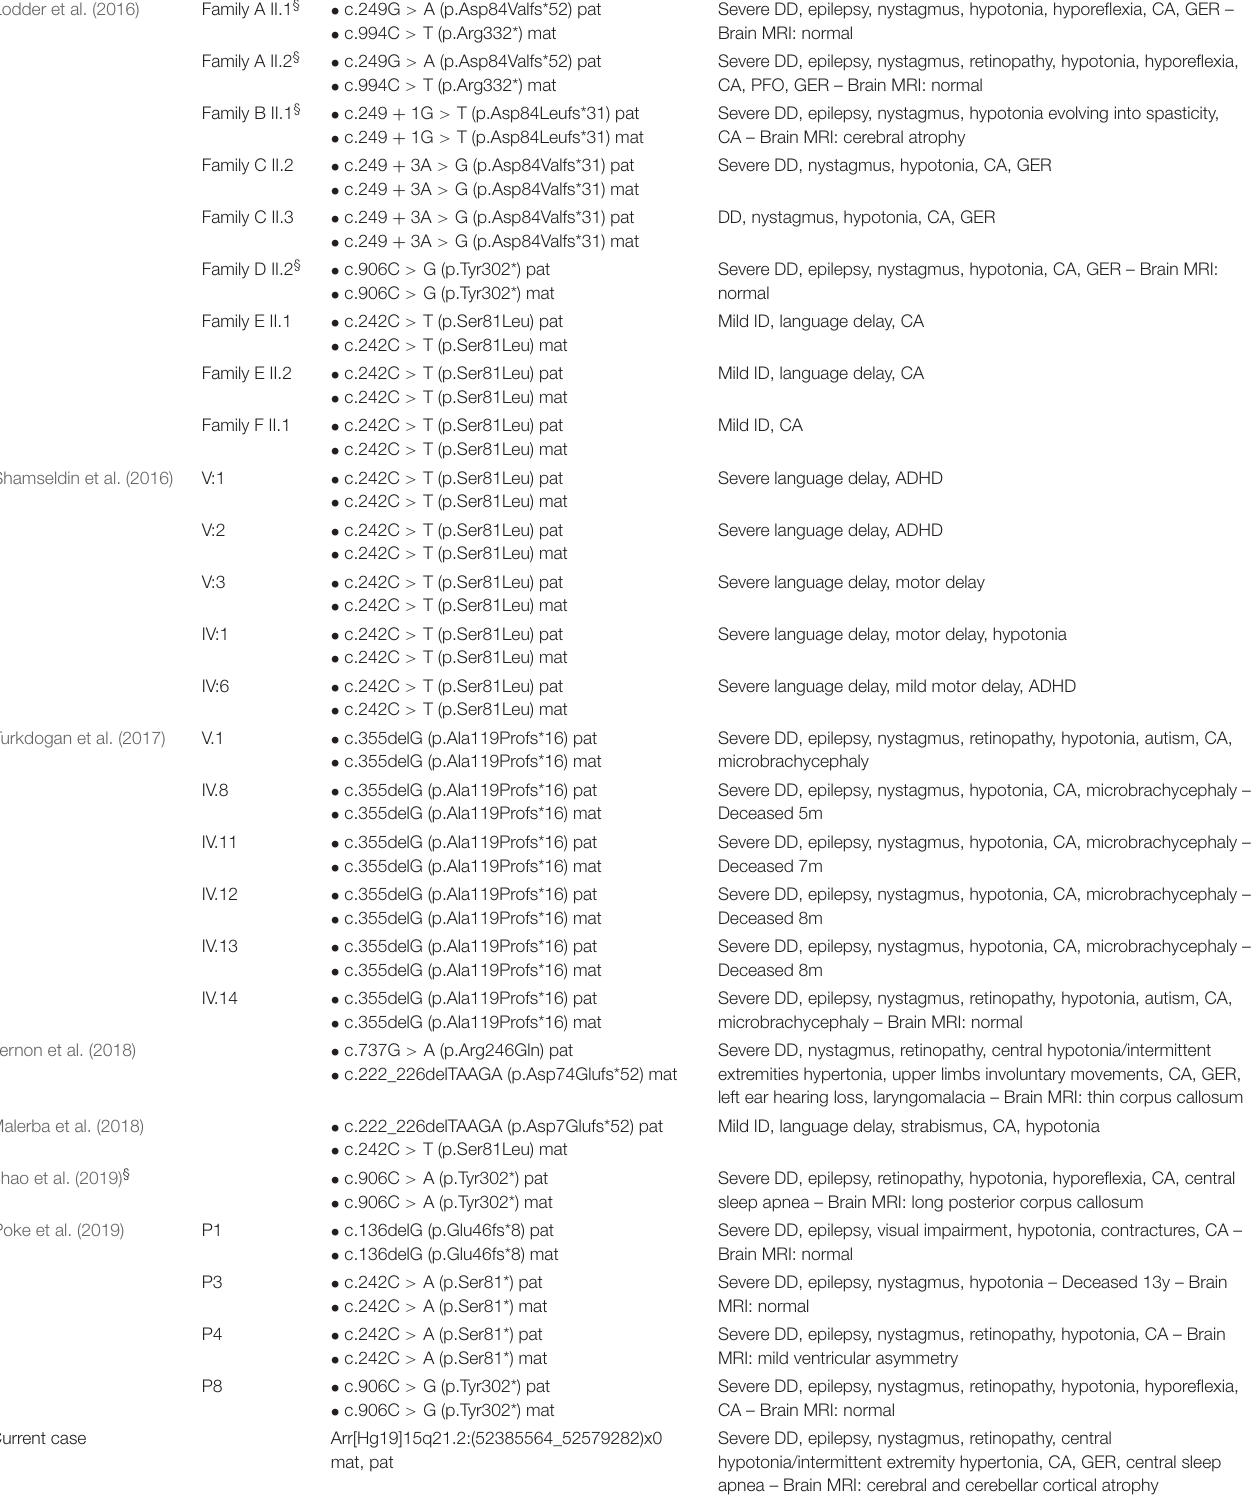
TABLE 1 | Summary of cases with GNB5 mutations so far reported compared to the present case with homozygous microdeletion. Lodder et al.